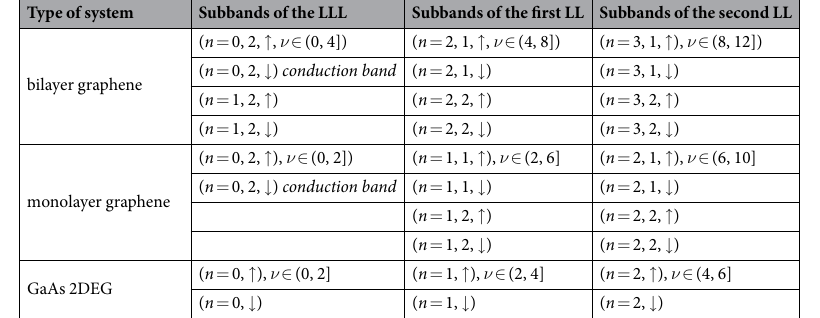
Table 1. Comparison of subband arrangements in bilayer graphene, monolayer graphene and GaAs 2DEG, and range (the nominal size of the cyclotron orbit corresponding to n is the corresponding filling rate ν = N N 0 + n (2 1) hc ; however, in the bilayer system, the orbit size can be reduced by flux leakage to the opposite eB